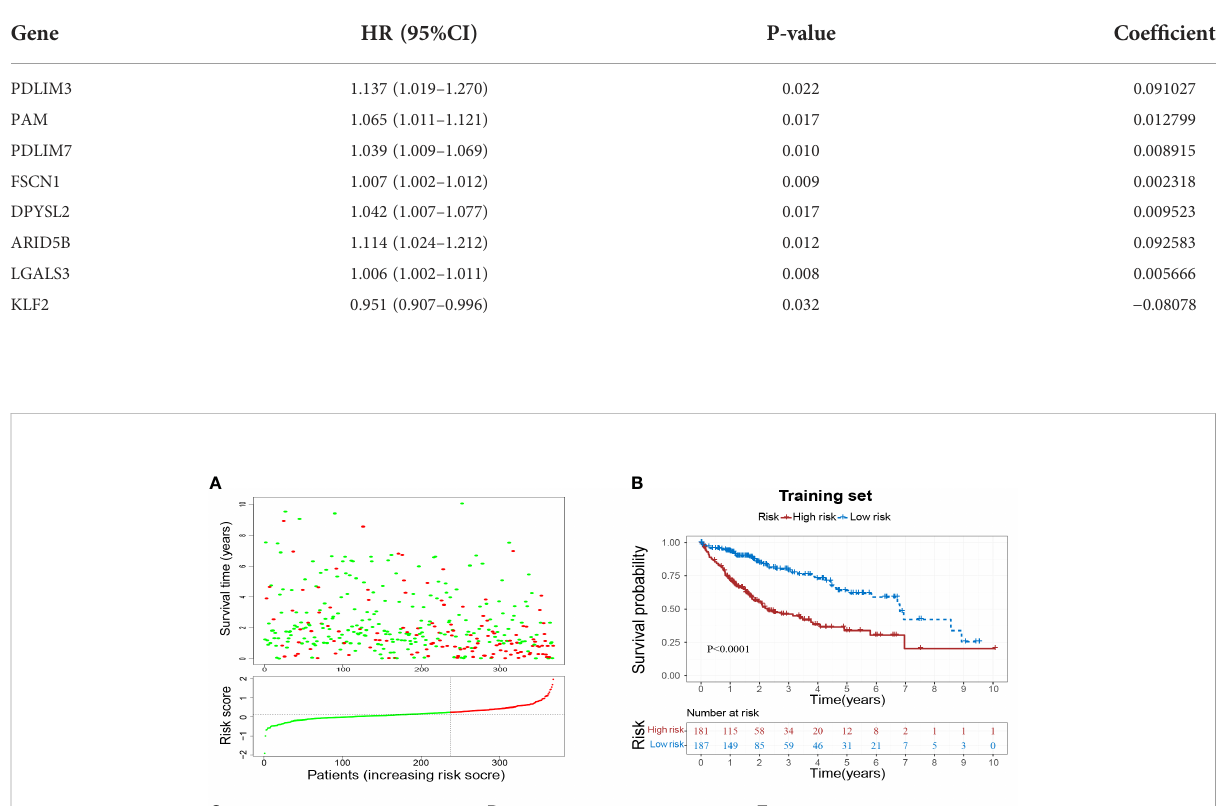
TABLE 1 Results of LASSO regression analysis. lasso, least absolute shrinkage and selection operator.